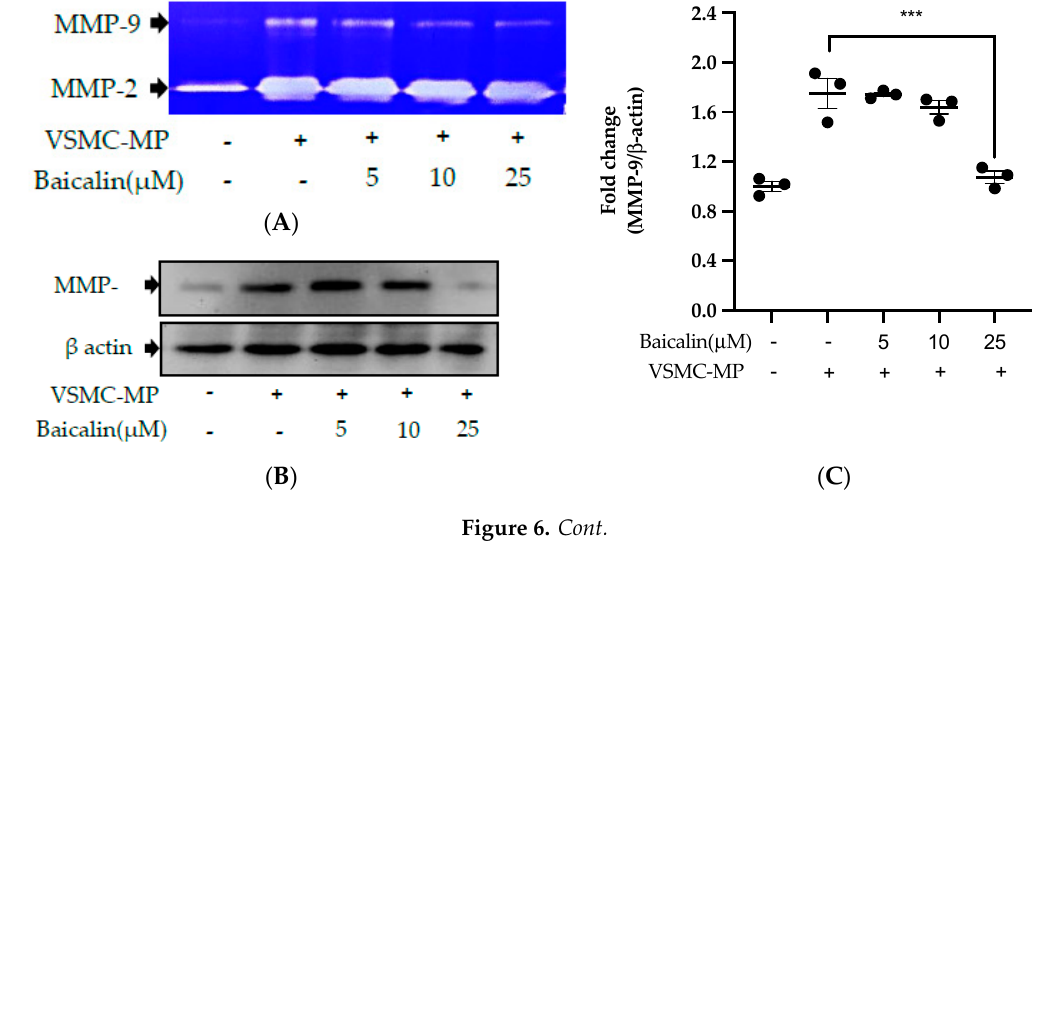
Figure 5. Effect of baicalin on VSMC-MP induced proliferation of VSMC. ( A ) VSMC were incubated with VSMC-MP and a various dose of baicalin for 48 h, followed by MTT solution for 4 h. The absorbance of purple formazan was taken at 540nm. ( B ) VSMC incubated with or without VSMC-MP and various doses of baicalin for 48 h were evaluated for proliferation by MTT method. ( C ) The cell lysate of VSMC treated with or without VSMC-MP and various doses of baicalin for 24 h and was